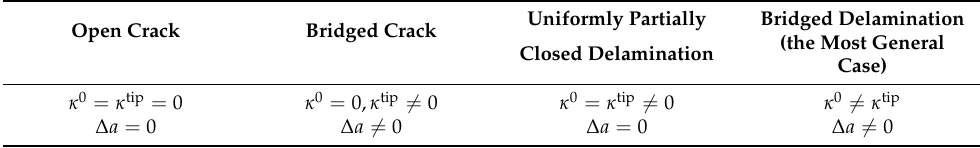
Figure 2. Stiffness variation for four kinds of delamination under consideration. Table 2. The characteristics of four kinds of delaminations considered in the